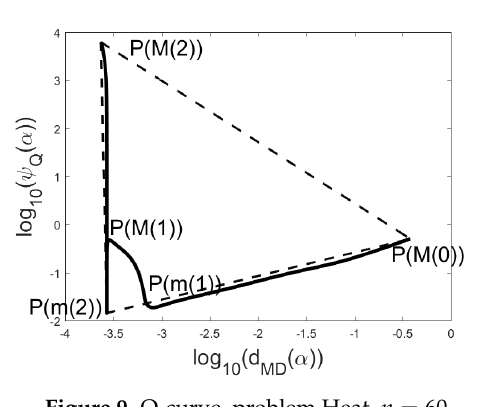
Figure 9. Q-curve, problem Heat, n = 60.